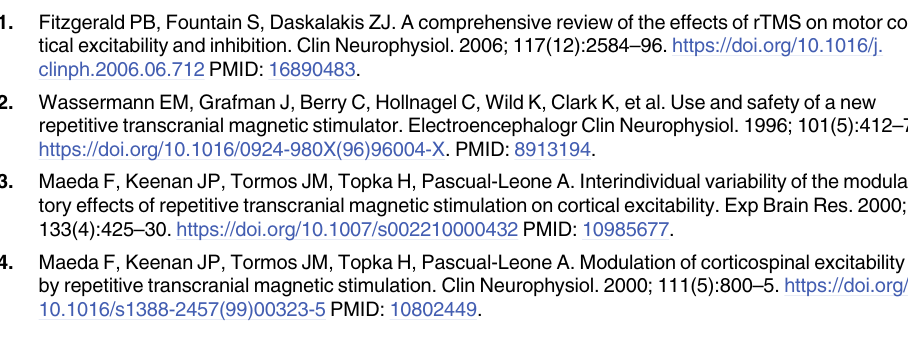
S1 Fig. Identification of CST fibers and infiltration of microglial cells. (A, B) CST fibers anterogradely labeled with BDA injected into the contralesional MI at the spinal levels above (C5) and below (C8/T1) the SCI lesion site in monkeys I (A; Control SCI) and C (B; RGMa- Ab+rTMS). Right panels are higher magnifications of the dorsolateral funiculus (dotted squares), and panels at the bottom are higher magnifications of lamina VII (rectangles) in the sections at the C8/T1 levels. (C, D) Microglial infiltration, as confirmed with Iba1 immu- nostaining, just below the SCI lesion site in monkeys I (C; Control SCI) and C (D; RGMa-Ab +rTMS). Lower panels are taken from the rectangles in the whole sections (upper panels). All sections were counterstained with Neutral red. Scale bars, 1